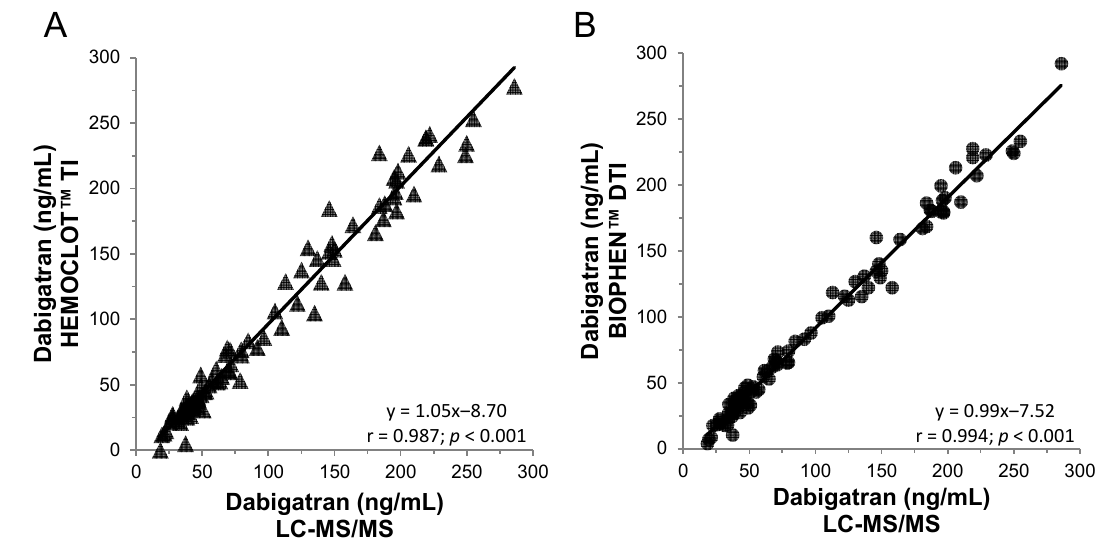
Figure 3. Correlation between anti-FIIa bioassays and the LC-MS/MS method on 100 dabigatran plasma samples from the RELY or phase 1 studies. ( A ) HEMOCLOT™ TI and ( B ) BIOPHEN™ direct thrombin inhibitor (DTI).